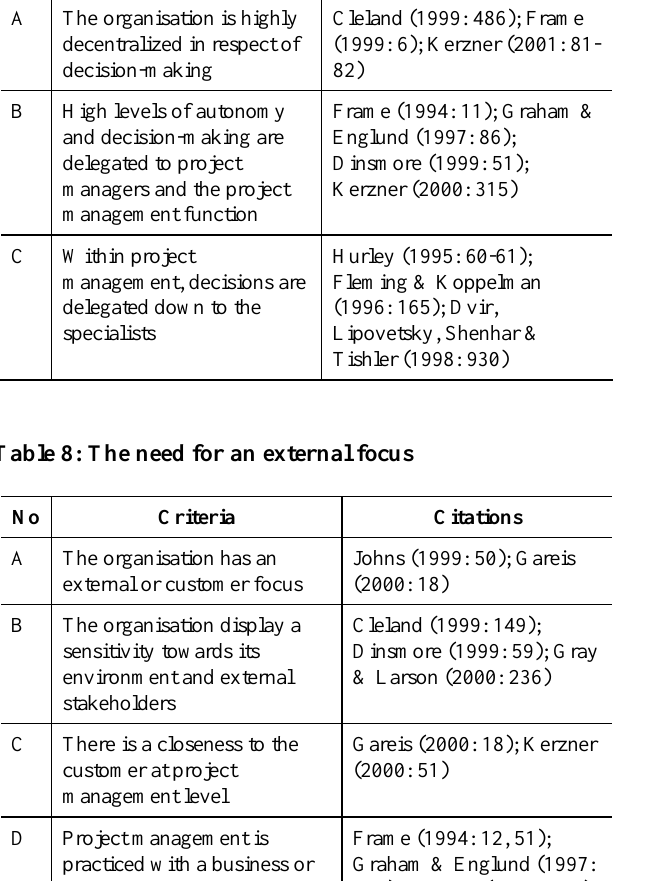
Table 7: The need for delegating decisions and autonomy No